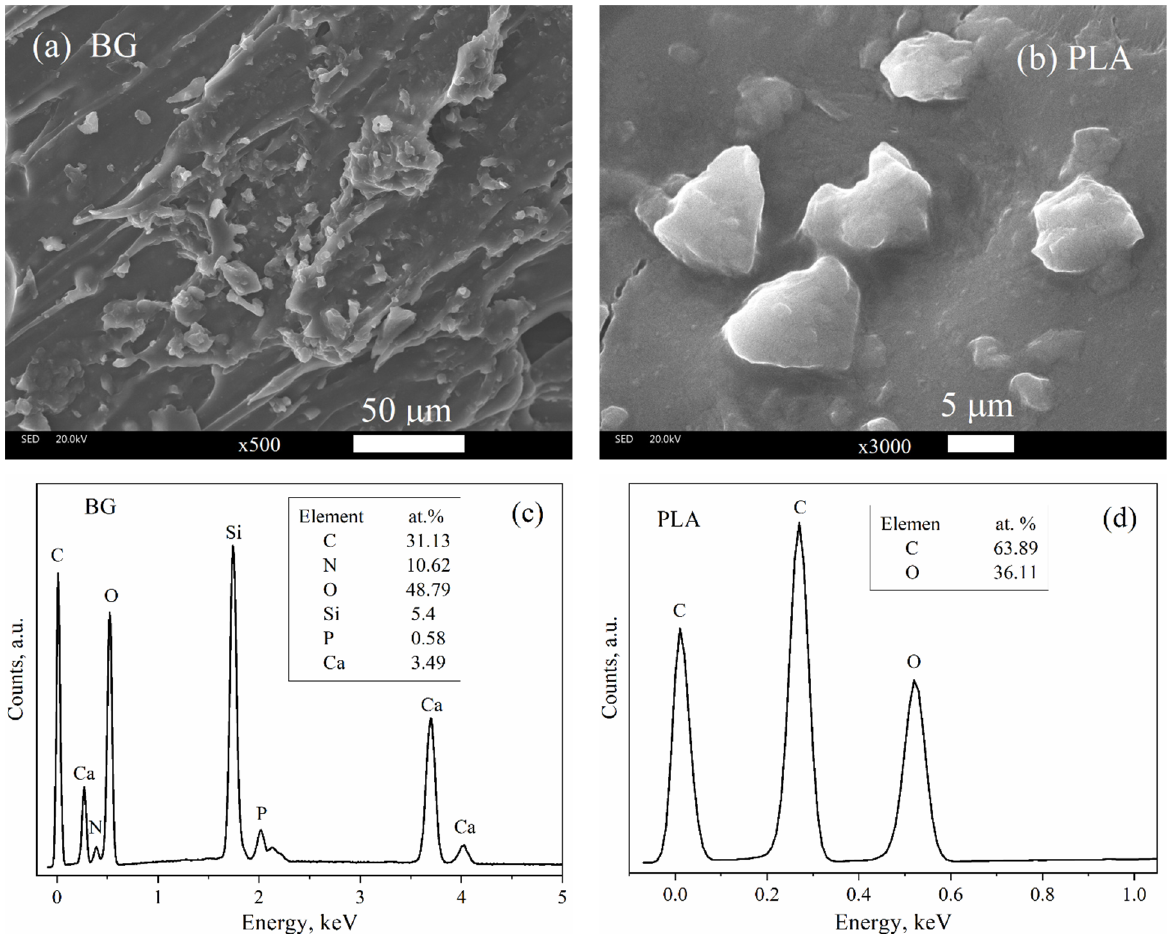
Figure 7. Morphology by SEM of ( a ) BG and ( b ) PLA; EDS chemical analyses of ( c ) BG and ( d ) PLA.